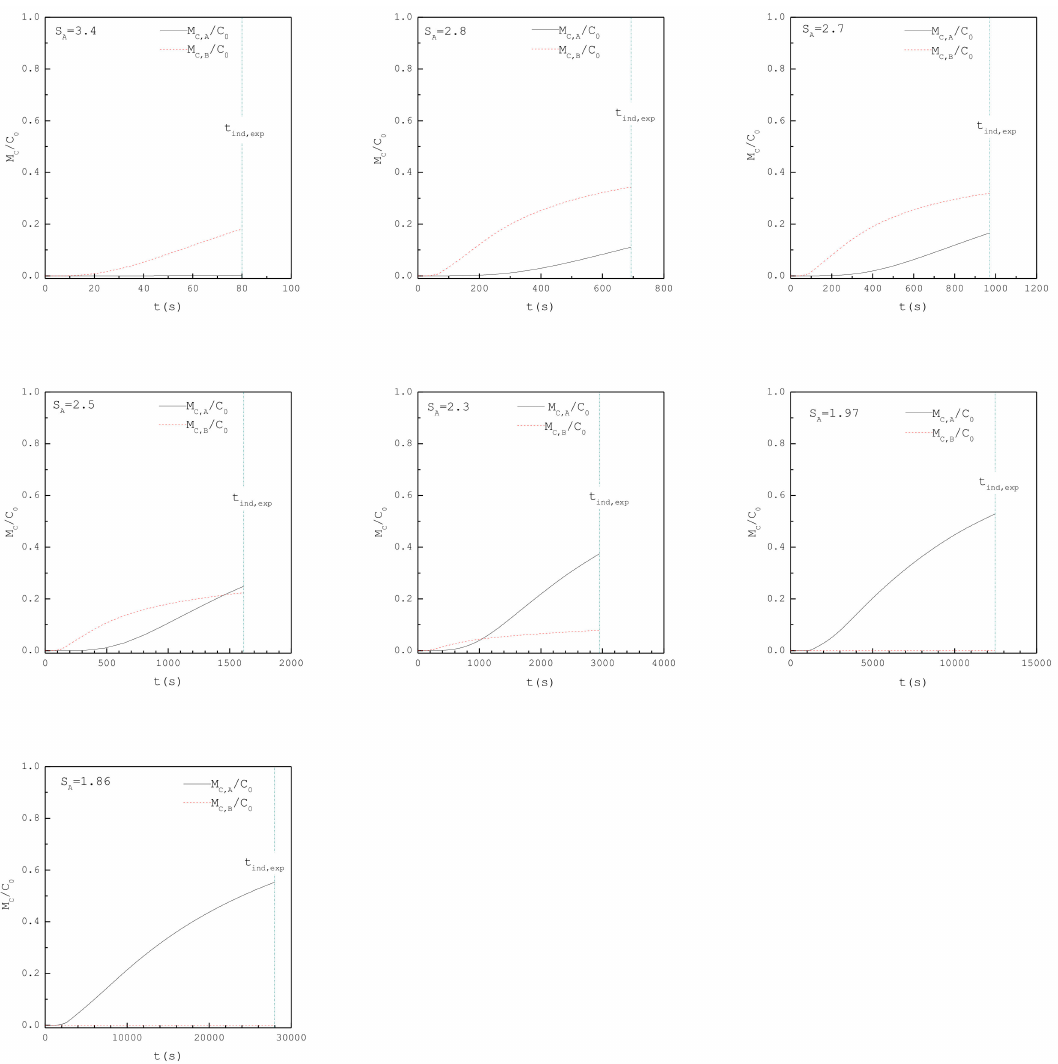
Figure 5. Variation of M C,A and M C,B with increasing time for various S A in the range t = 0 − t ind